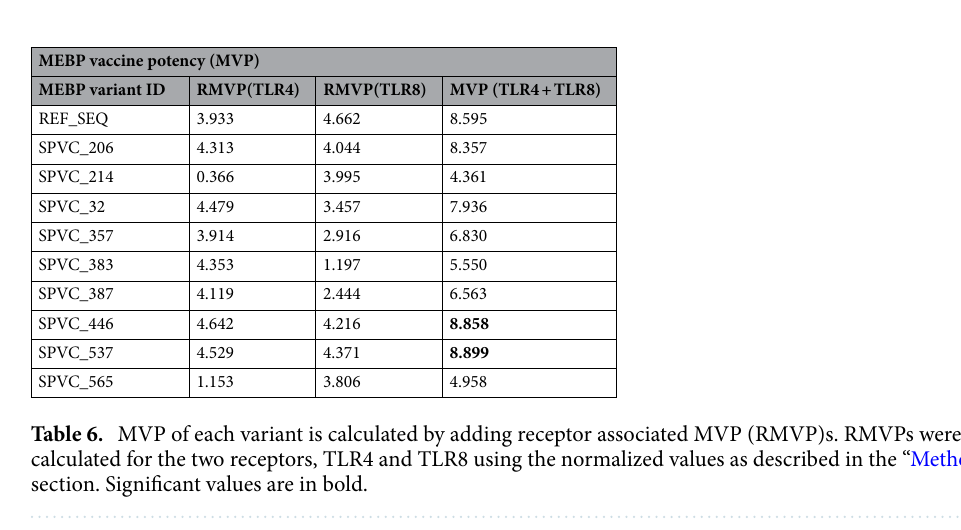
Figure 6. Concentration of IFN-γ for all MEBP variants ‘( a ) with adjuvant + HIS-tag, ( b ) without adjuvant + HIS-tag) after the 1st, 2nd, and 3rd doses (X axis—vaccine constructs, Y axis—ng/ml).